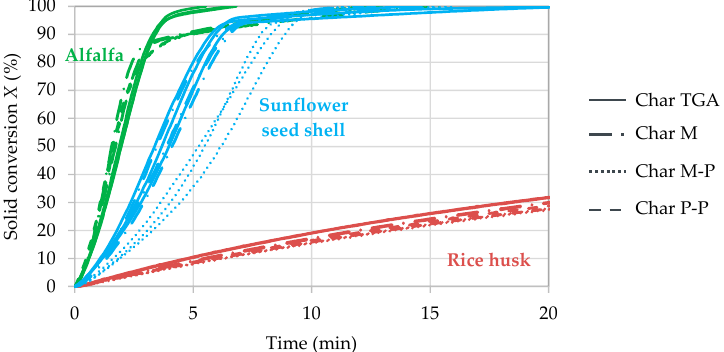
Figure 9. Solid conversion of chars as a function of time during gasification (0.05 L·min − 1 mixture 80 vol % N 2 /20 vol % H 2 O, 800 °C).